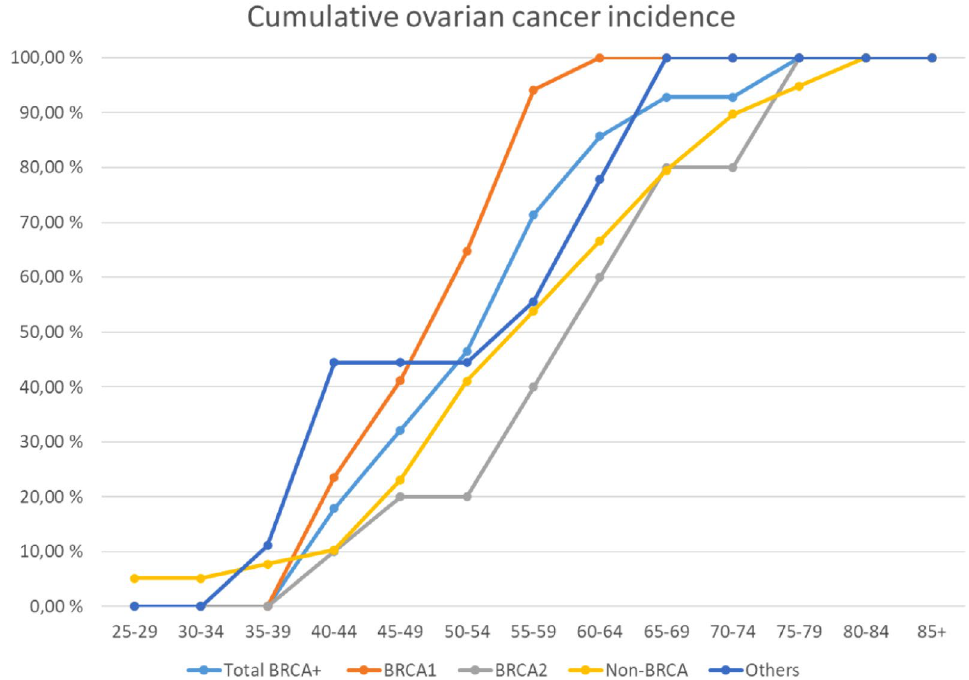
Figure 3. The onset of ovarian cancer in BRCA -families, non- BRCA families with high risk and others. Exact values are marked with circles. Smoothing is used to make the curves more